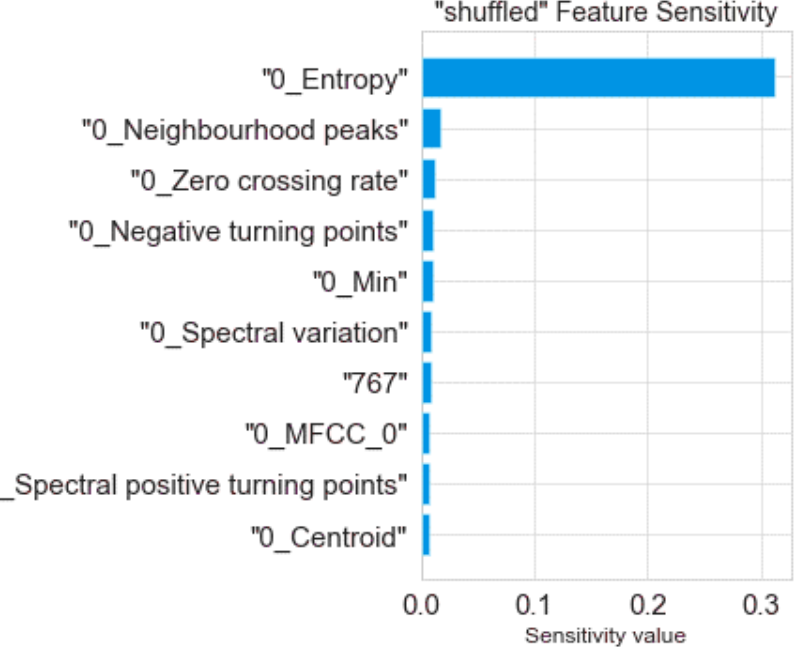
Figure 17. SHAP value of the proposed model.